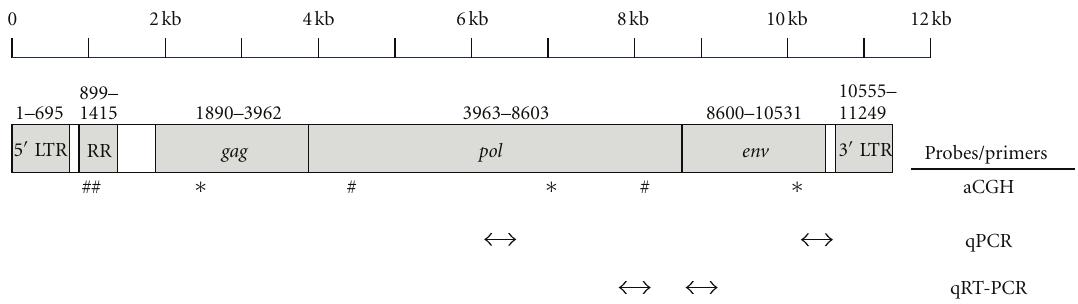
Figure 2: ZFERV Genomic Organization. The ZFERV retrovirus is comprised of two 695 bp long terminal repeats (LTRs), a 517 bp repeat region (RR) containing 9 direct repeats, and ORFs for 3 proteins: gag , pol , and env [11]. The gag and pol genes share the same reading frame and are predicted to be translated from one transcript by read-through of a stop codon; env uses a di ff erent reading frame and is probably a distinct transcript [11]. aCGH probe sites are shown beneath the ZFERV genome schematic: probes found on Zv6 chromosomes 7 ( ∗ ) and 14 ( # ) are dispersed throughout ZFERV. One aCGH probe had sequences corresponding to the RR ( ## ), and has multiple binding sites in this area. The 5 remaining aCGH probes map to ORFs. Amplicons from qPCR and qRT-PCR assays are also depicted (not shown to scale). The pol and env qPCR products are 168 and 169 bp, respectively; qRT-PCR products are 225 bp for pol and 234 bp for env